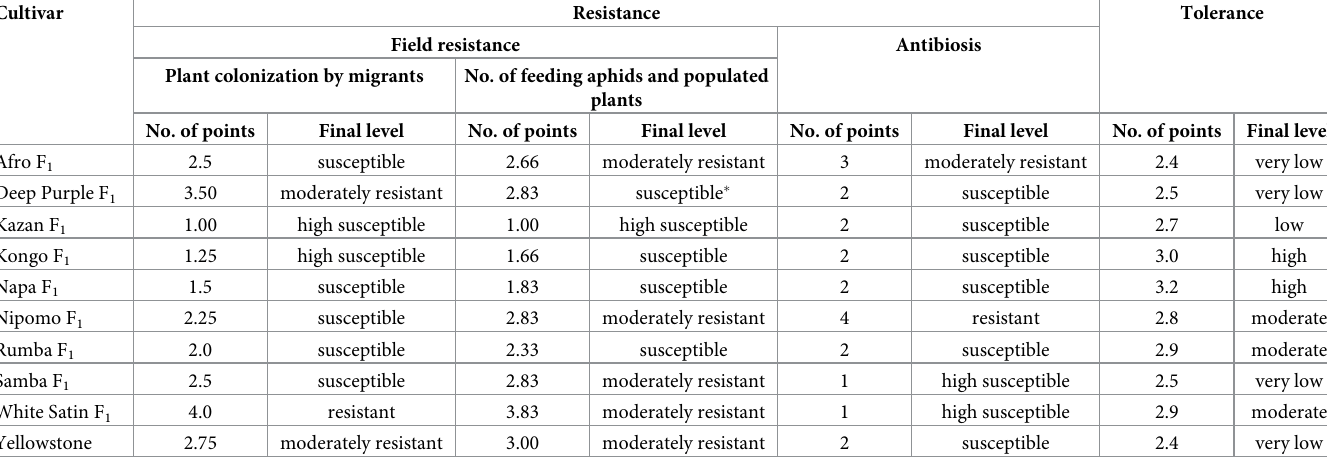
Table 2. Levels of resistance and tolerance of ten carrot cultivars to the hawthorn-carrot aphid, Dysaphis crataegi . Cultivar Resistance Tolerance Field resistance Antibiosis Plant colonization by migrants No. of feeding aphids and populated